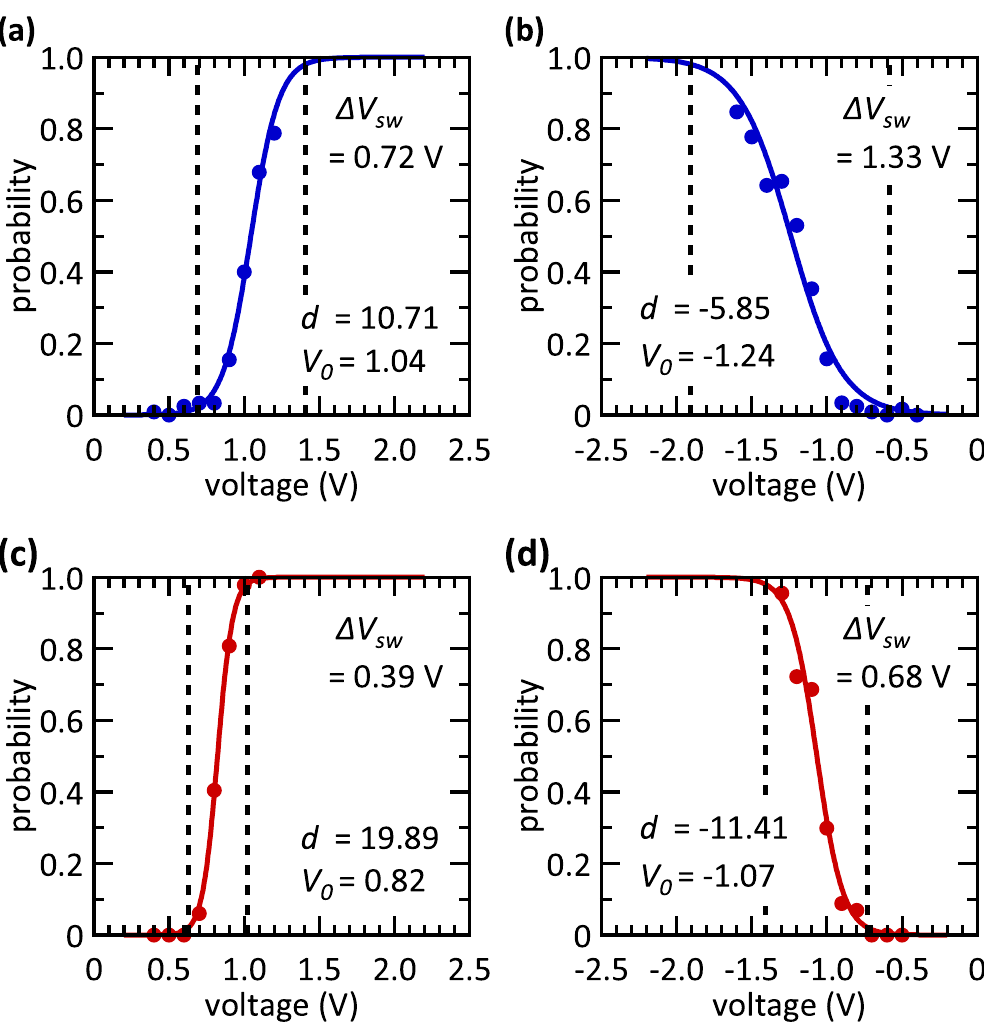
Figure 1. Switching probability of polycrystalline and amorphous devices dependent on the applied voltage. The dots are measured data points and the solid lines are fits of Eq. (1). The parameters of the fits, i.e. d and V 0 , are given in the plots. Furthermore, the size of the switching windows ΔV sw is given. In ( a , b ) the set and reset behaviour of the polycrystalline devices are shown, respectively. The same is depicted in ( c , d ) for the amorphous devices. The switching probabilities are determined by measuring 128 polycrystalline and 128 amorphous devices with read-out and switching times of 10